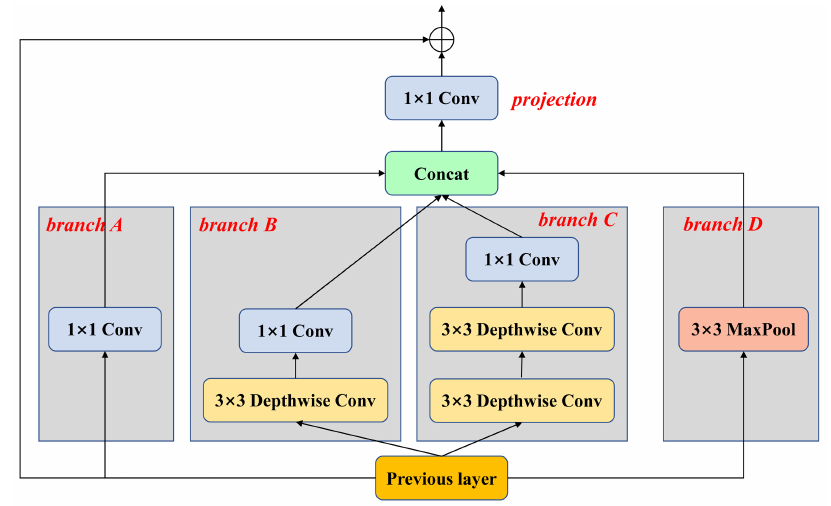
Figure 3. Principle and structure diagram of lightweight